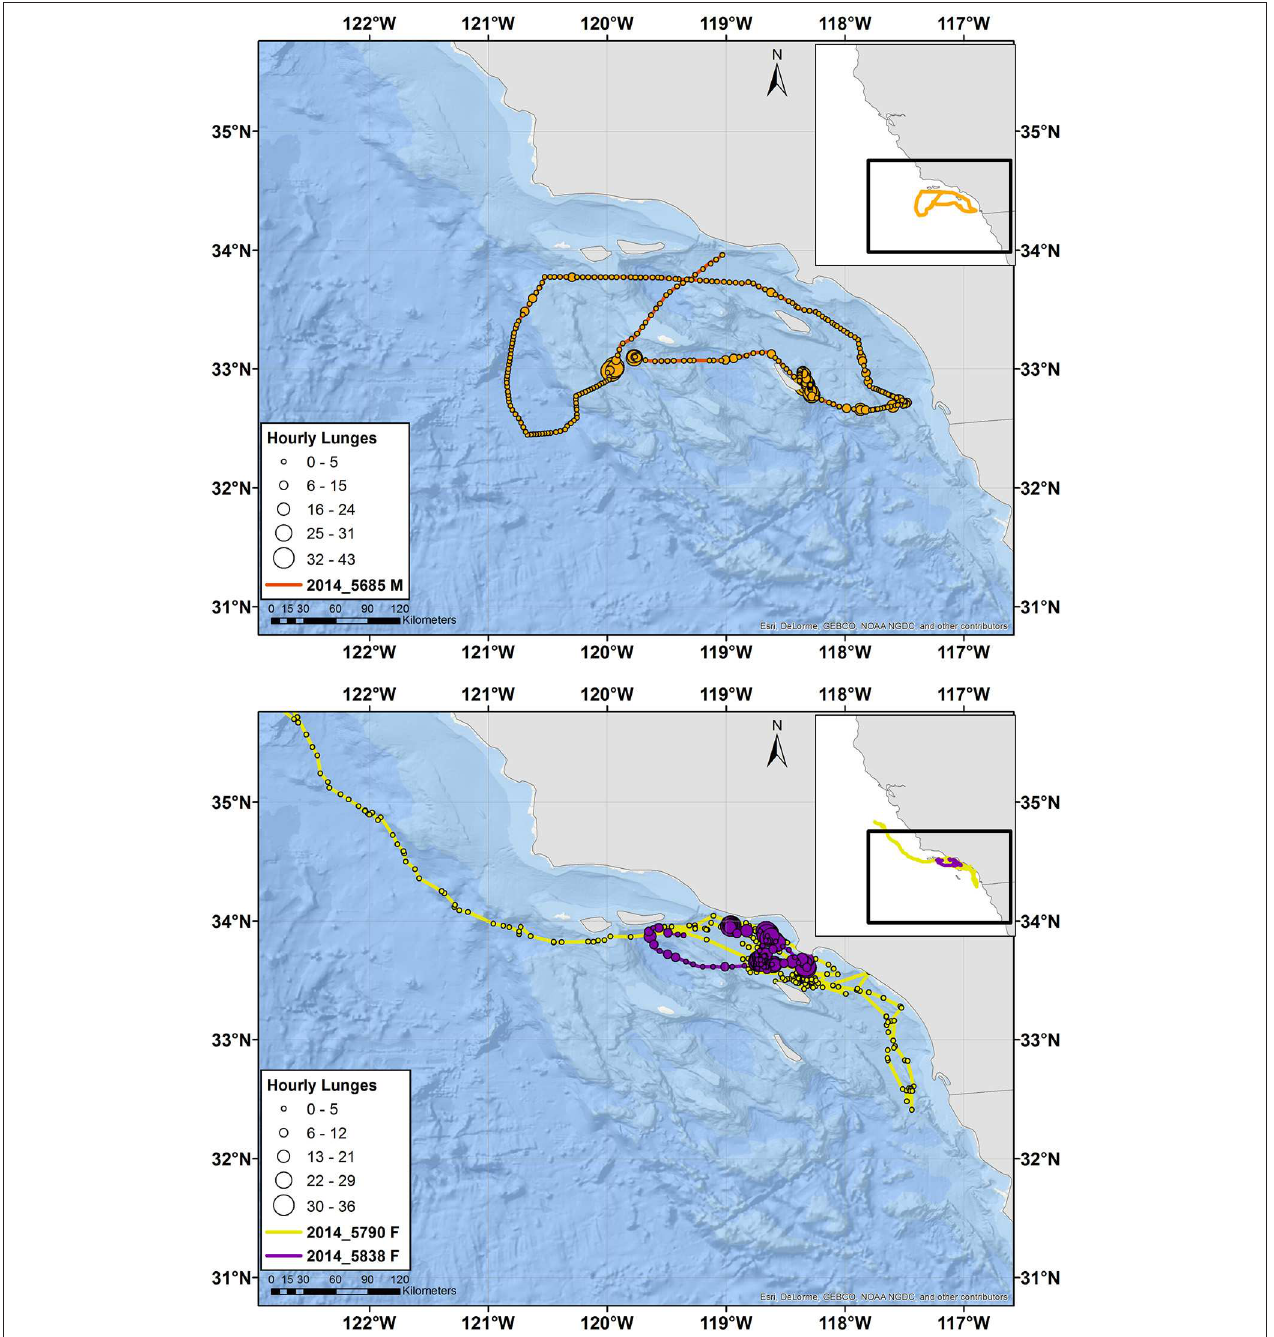
FIGURE 3 | Tracks of male (top) and female (bottom) fin whales instrumented with ADB tags off southern California in August 2014. Main maps zoom in on southern California, while the inset maps show the full extent of the tracks with the zoomed region identified by a black square. Circles indicate hourly average locations, with circle size scaling to number of feeding lunges per hour and circle color indicating a different individual, per the tag number shown in the key. Note that the tag for Whale # 2014_5790 was not recovered and therefore no feeding data are available, but locations received through Argos are shown. The tracks for two additional fin whales of unknown sex are presented in Supplementary Figure 4 . being tagged in the same areas; in one case on the same day (e.g., allow for fine-scale resolution of their movements. In contrast to blue Whale # 2014_5655 and fin Whale # 2014_5685), and in two blue whales, there were no instances of close proximity between cases of fin whales (Whale #s 2014_5790 and 2014_5838) tagged fin whales, or between blue and fin whales, despite both